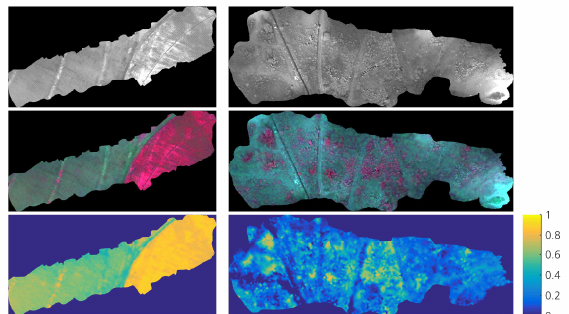
Figure 9. Left: Crop field near Potchefstroom, Northwest State, South Africa. Right: Part of the nature reserve Bateleur, Province Limpopo, South Africa, where a believed to be extinct butterfly species was rediscovered (Mecenero et al., 2013).